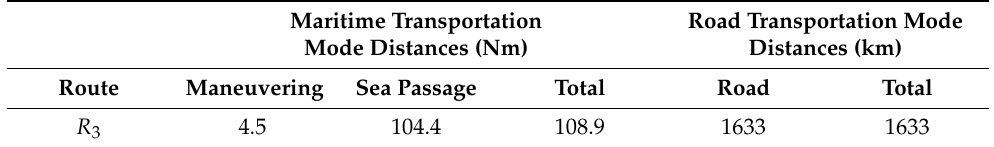
Table 15. Determined distances on route R 3 .